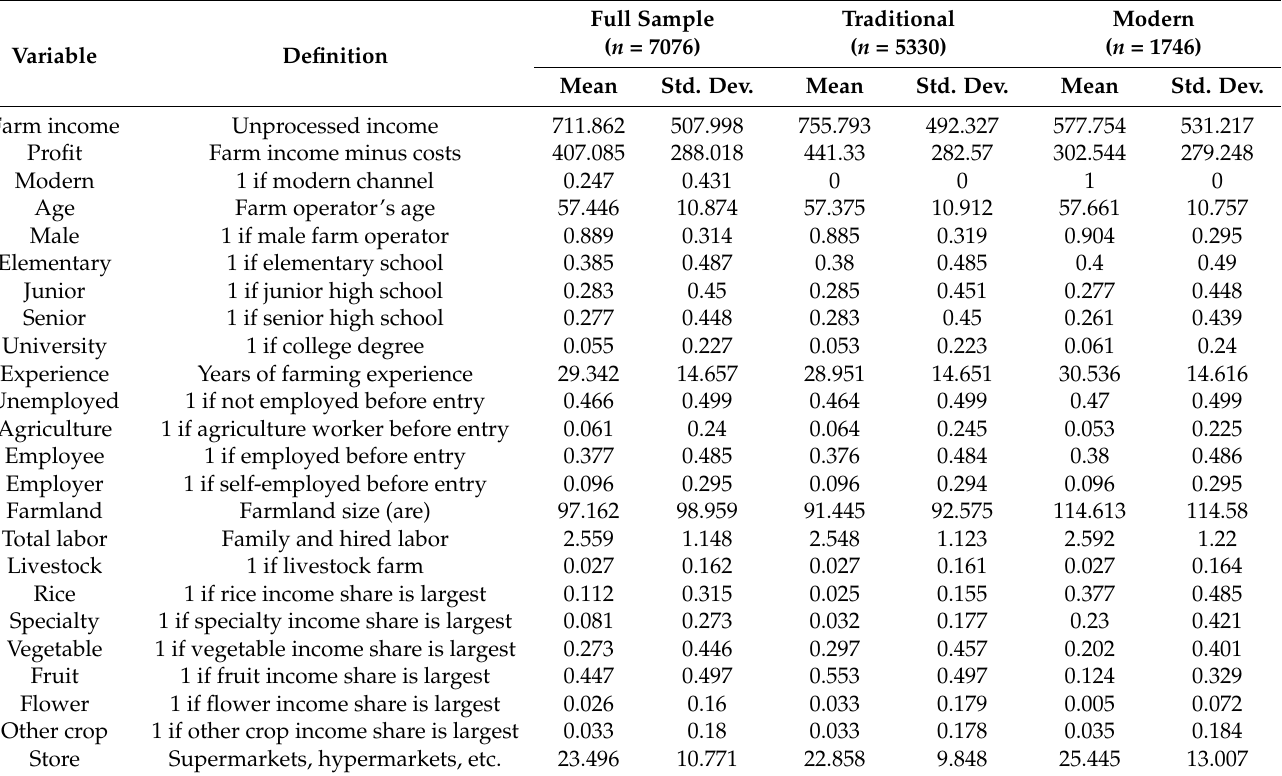
Table 1. Variable definition and summary